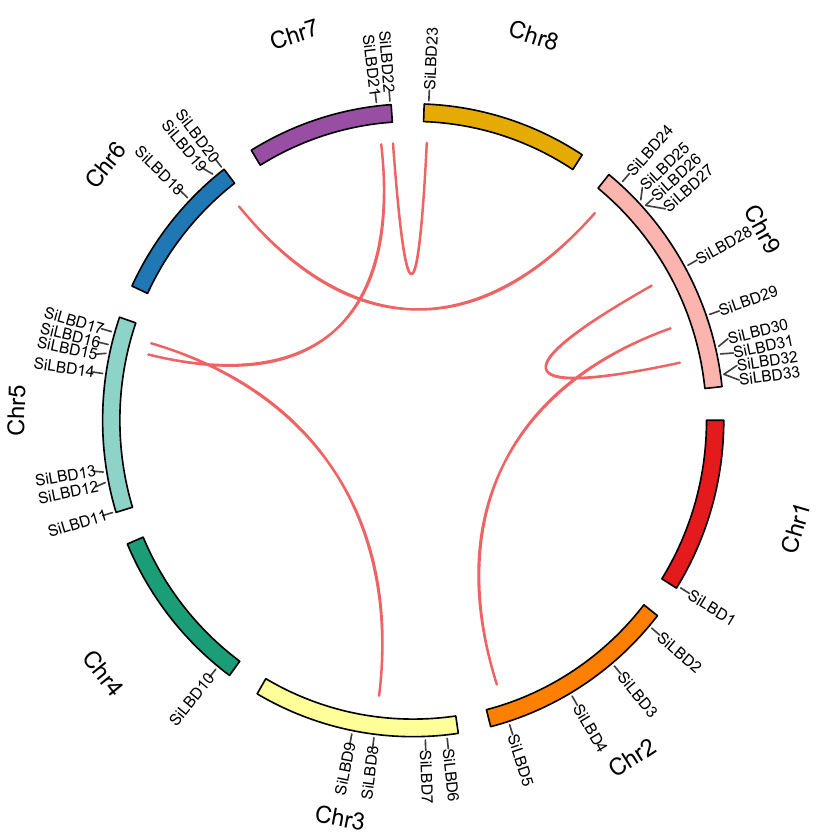
Figure 1. Chromosome location and segmental duplication of SiLBD genes. Different chromosomes are shown by different colors, and the gene pairs are indicated by lines.